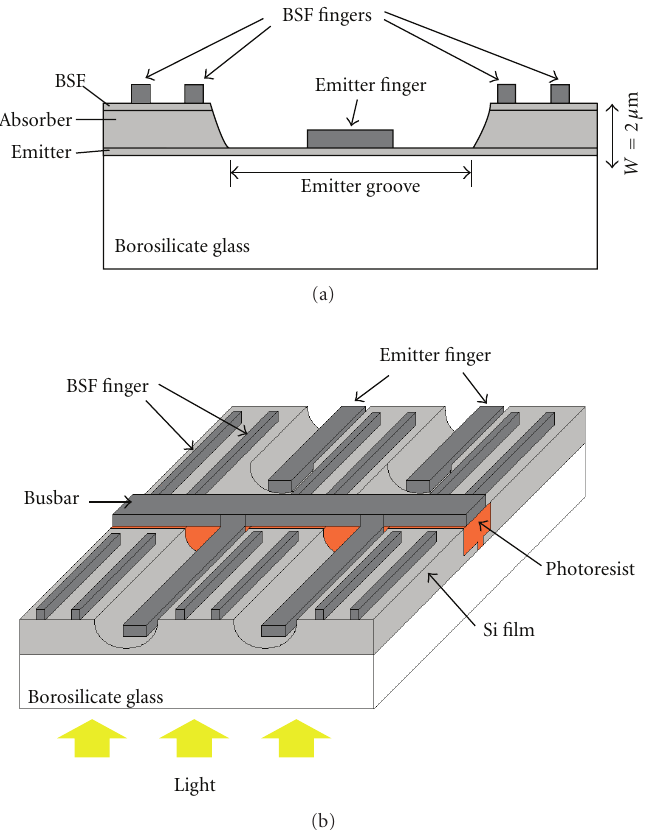
Figure 2: (a) Cross-sectional schematic of a poly-Si thin-film solar cell on glass with the aligned bifacial metallisation. (b) Layout of the aligned bifacial interconnected metallisation as processed in this work. In the figure, the photoresist acts as an isolation layer to prevent shunting between adjacent cells (images are not to